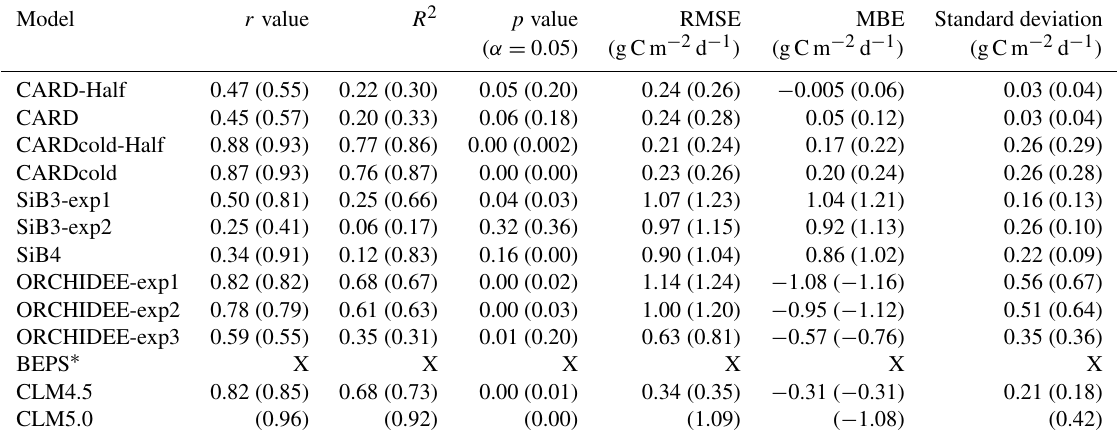
Table 2. Pearson’s linear r , R 2 , p value, standard deviation, root mean square error (RMSE), and mean bias error (MBE) for TBM-MIP and all CARDAMOM experiments for Niwot Ridge tower-derived mean spring (March–May) GPP. Open values reflect statistics for the 2001–2018 period, while values in parentheses represent the 2012–2018 period. All relevant statistics are calculated at a 5% significance